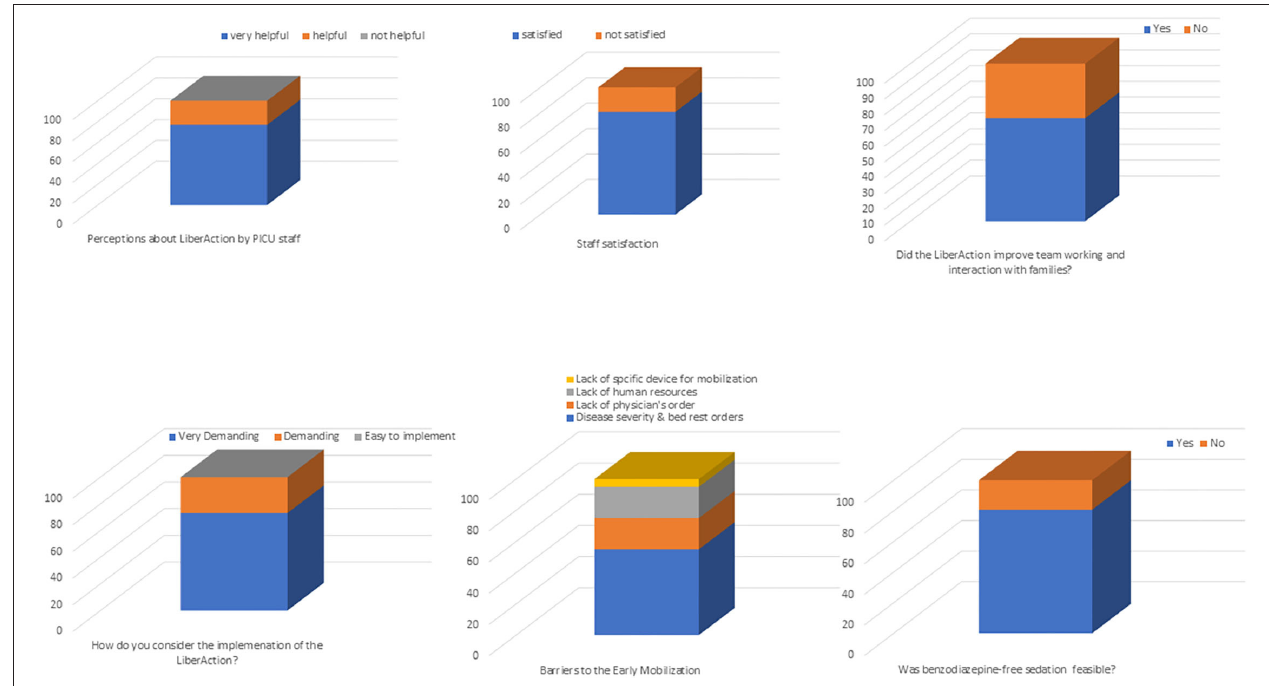
FIGURE 2 | PICU staff perceptions of the LiberAction